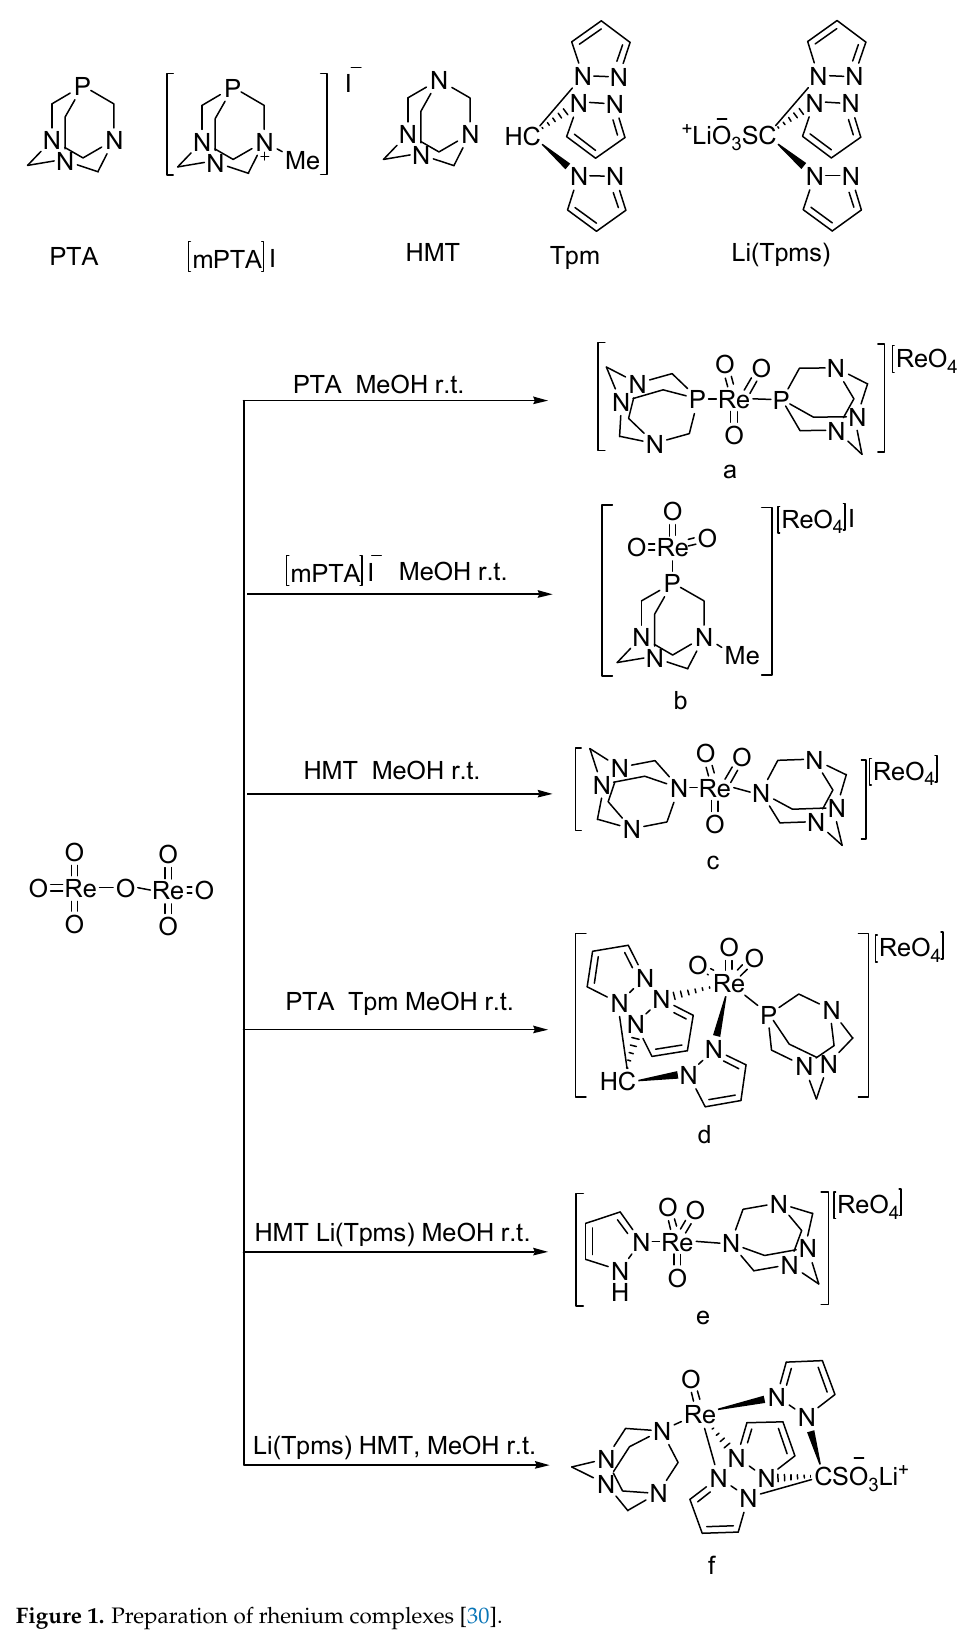
Figure 1. Preparation of rhenium complexes [30].